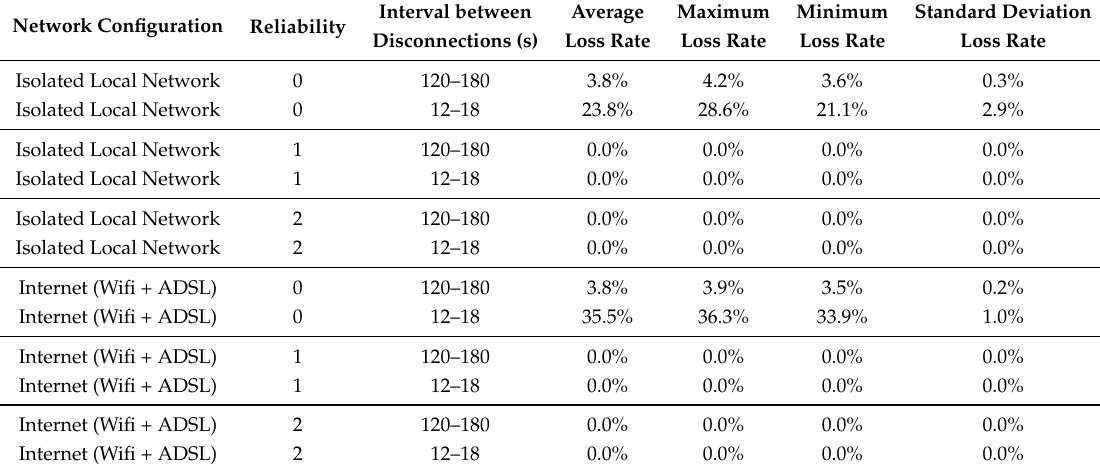
Table 5. Results from the Evaluation of Message Delivery Efficiency in Intermittent Connection